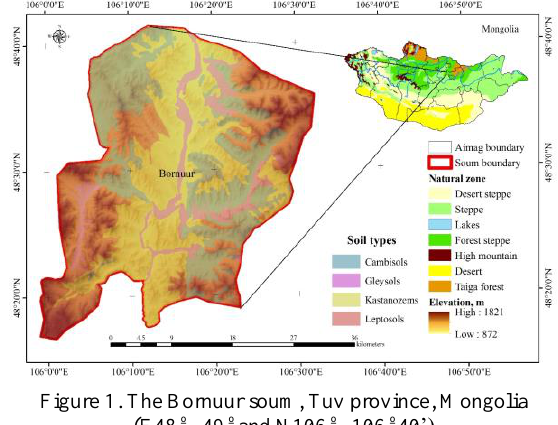
Figure 1. The Bornuur soum, Tuv province, Mongolia (E48 º - 49 º and N106 º - 106 º 40’)